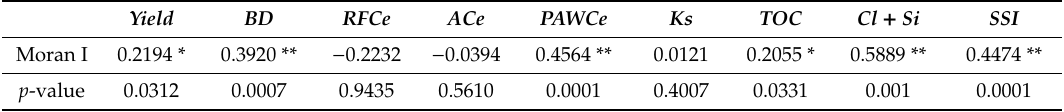
Table 3. Moran’s I spatial autocorrelation statistics.